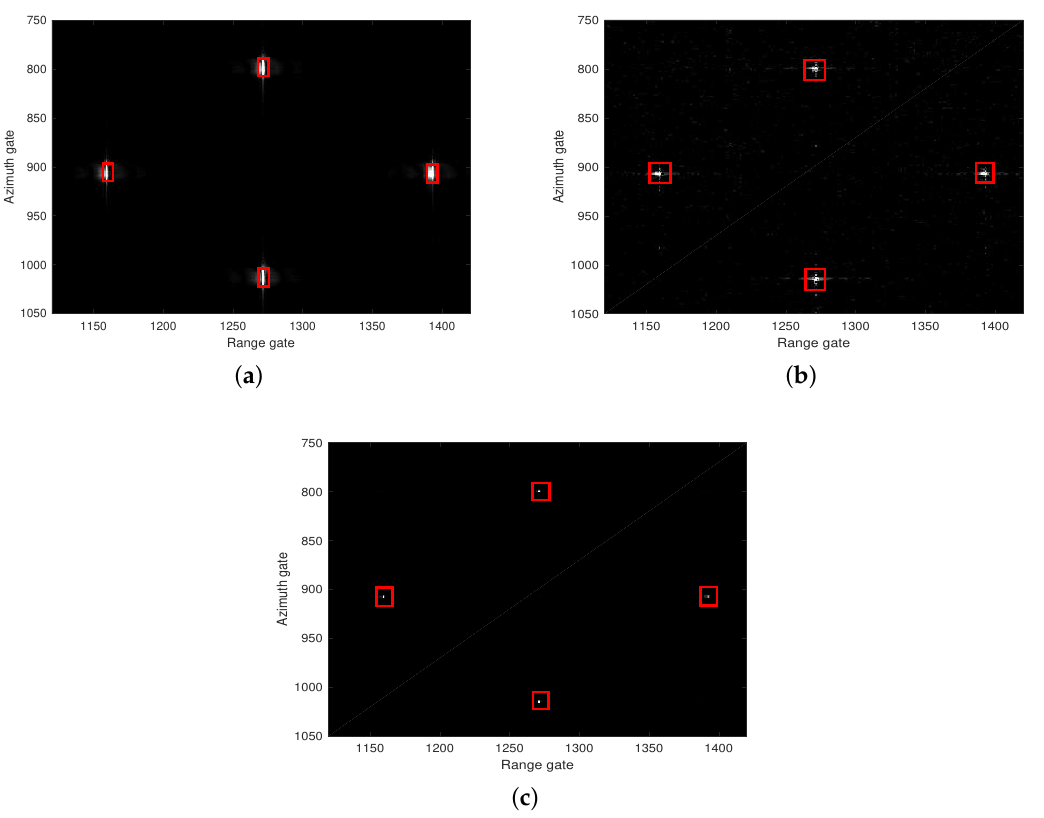
Figure 18. GMTI results: ( a ) RD with oversampled raw data; ( b ) CS with 50% of the oversampled raw data; ( c ) HVB-DCS with 37.5% of the oversampled raw data. The red rectangle indicates the moving target. The partial enlarged result is shown in the upper right corner of the SAR